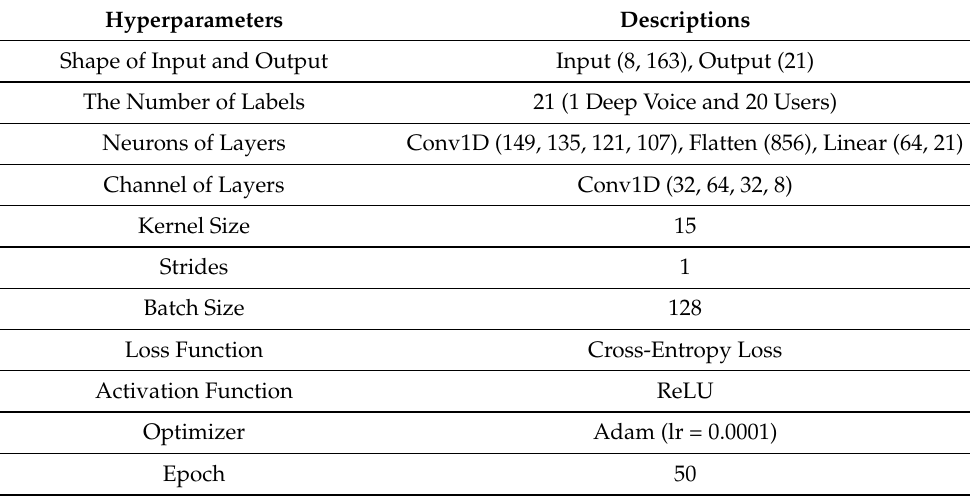
Figure 4. Structure of classifier for authentication and detection. Table 3. Details of hyperparameters of